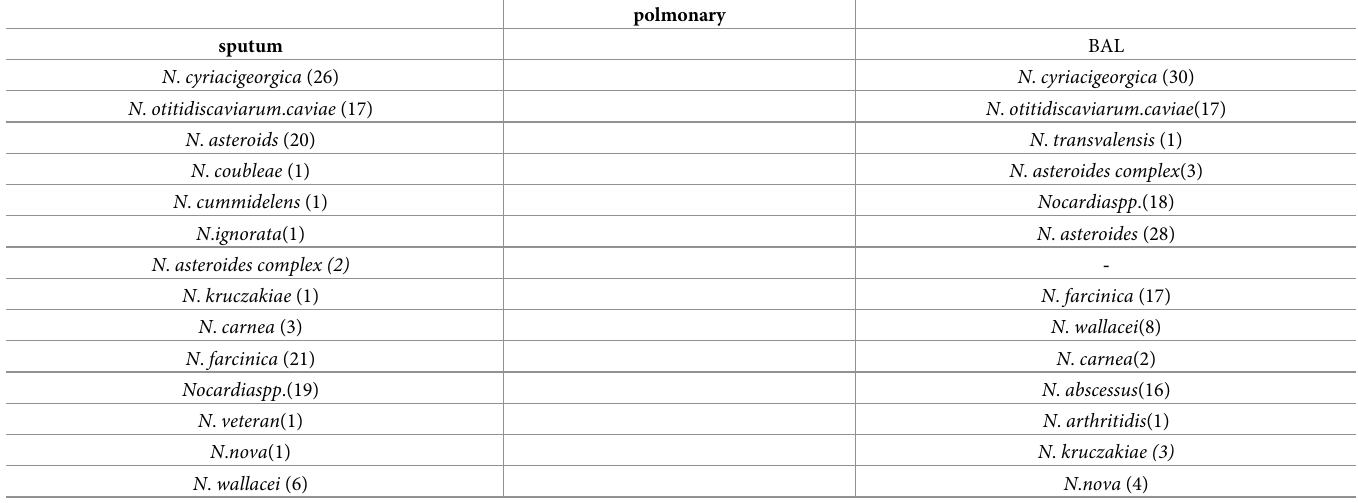
Table 4. The distribution of pulmonary Nocardiosis specimens.